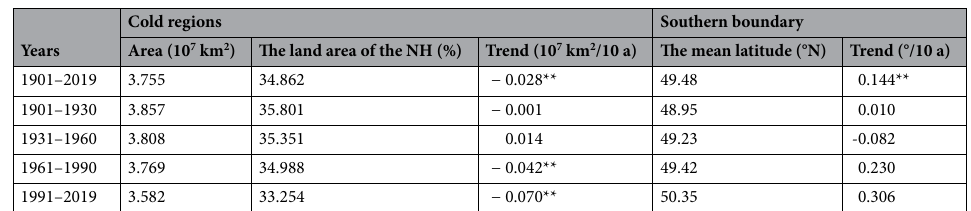
Cold regions Southern boundary Years